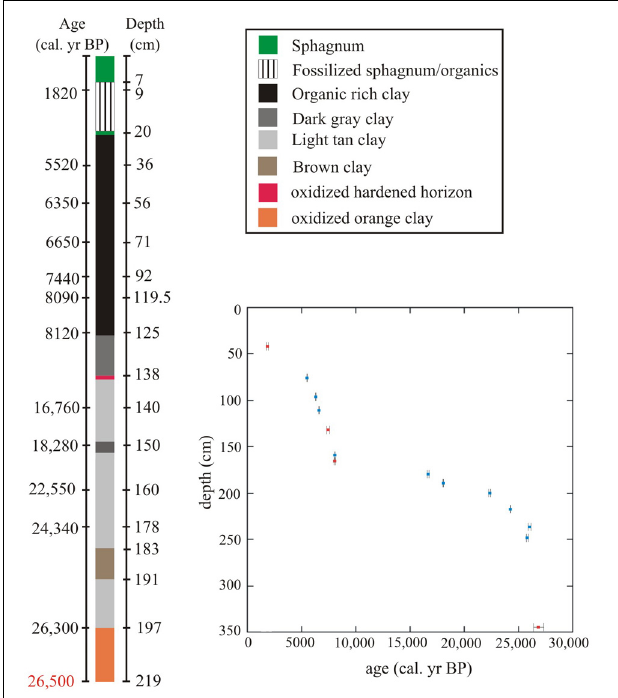
FIGURE 2 | Core description for 219cm sampled for pollen analysis (total core length 627cm). Samples subjected to 14 C analysis have age (left) and depths (right) listed on either side of the core. The 26,500 cal. year BP mark is an interpolated age for the lowest sample taken for fossil pollen analysis, not an actual 14 C date. Depths for points of change in sedimentology are only marked at right side of core. Inset: Paul’s Bog age model for the last 26,000 cal. year BP based on a 14 C chronology. Red rectangles signify dates that were cross-correlated from the 2004 core, blue rectangles signify dates taken from 2005 core. 2 sigma error of 14 C dates shown by error